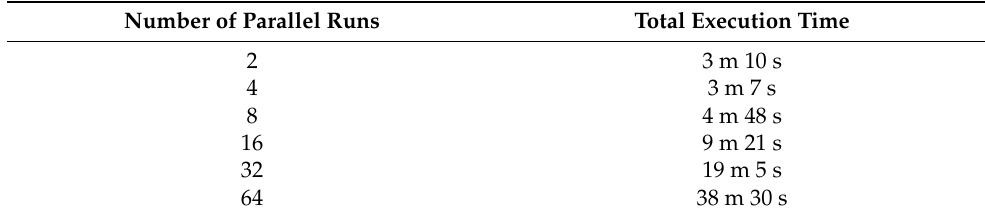
Table 3. Execution times of multiple parallel